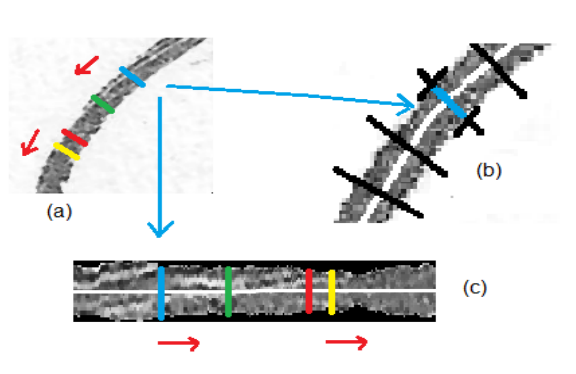
Figure 5. Rectification of Graphemes. ( a ) Segment of Original Simple Grapheme ; ( b ) Construction of Rectified Image; ( c ) Resulting Rectified Image.